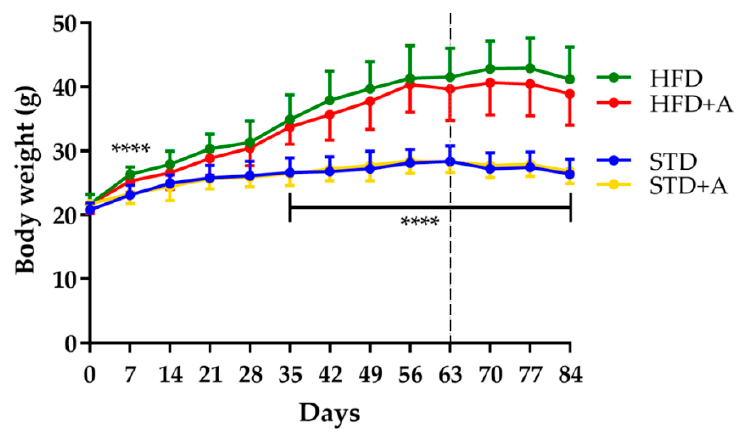
Figure 2. Body weight definitive di ff erences between diet groups were established until day 35, **** p < 0.0001 by one-way ANOVA / Tukey’s test. Alliin treatment (day 63, slashed line) did not have an e ff ect on body weight. STD, standard diet group; STD + A, standard diet + alliin treatment group; HFD, high-fat diet group; HFD + A, high-fat diet + alliin treatment group.